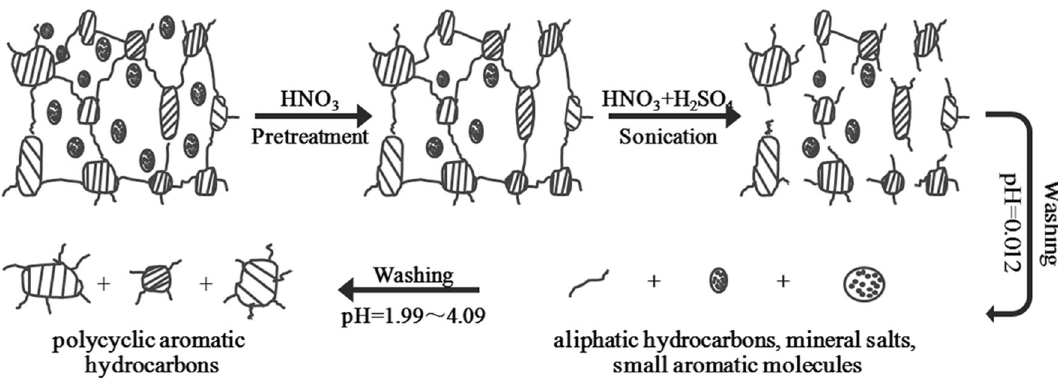
Fig. 7 Schematic diagram of depolymerization processes of the coal samples by oxidative acid treatment